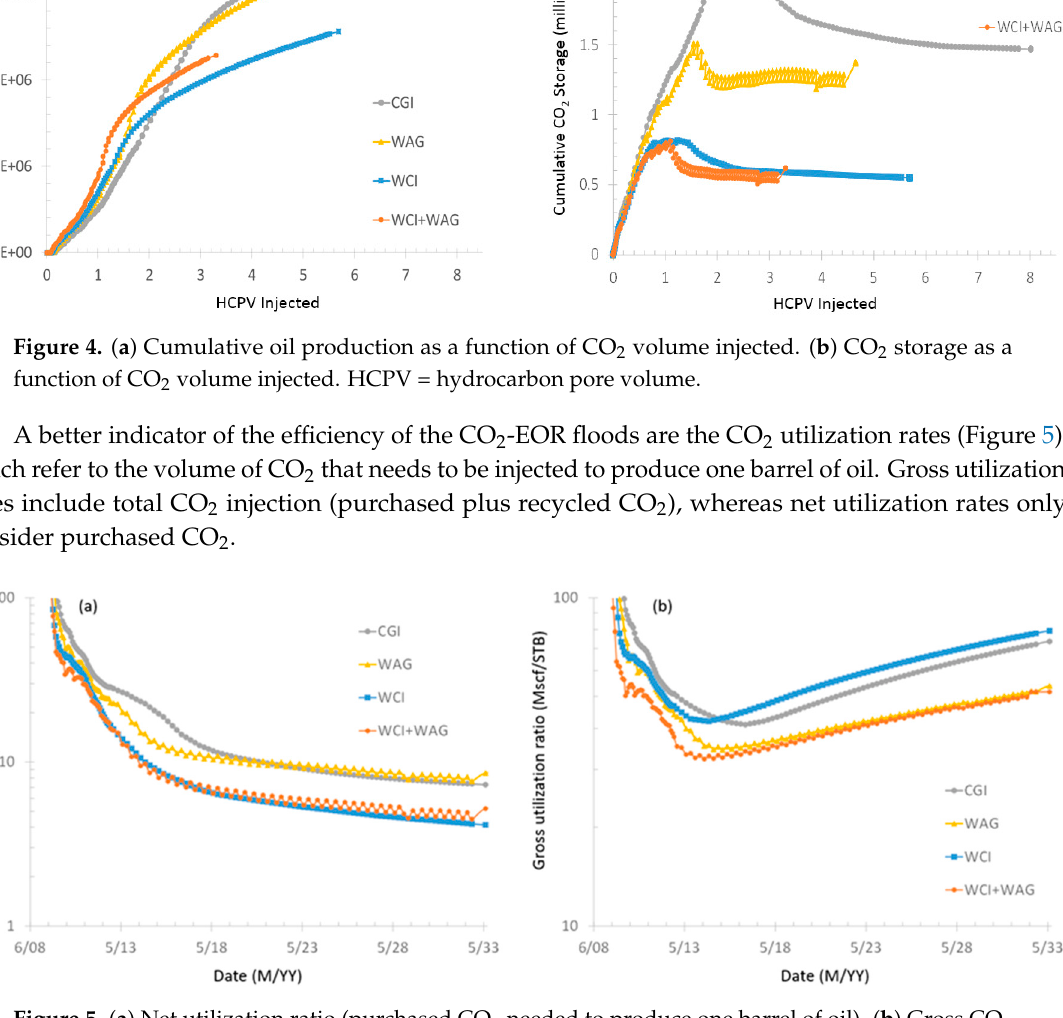
Figure 5. ( a ) Net utilization ratio (purchased CO 2 needed to produce one barrel of oil). ( b ) Gross CO 2 utilization ratio (purchased plus recycled CO 2 needed to produce one barrel of